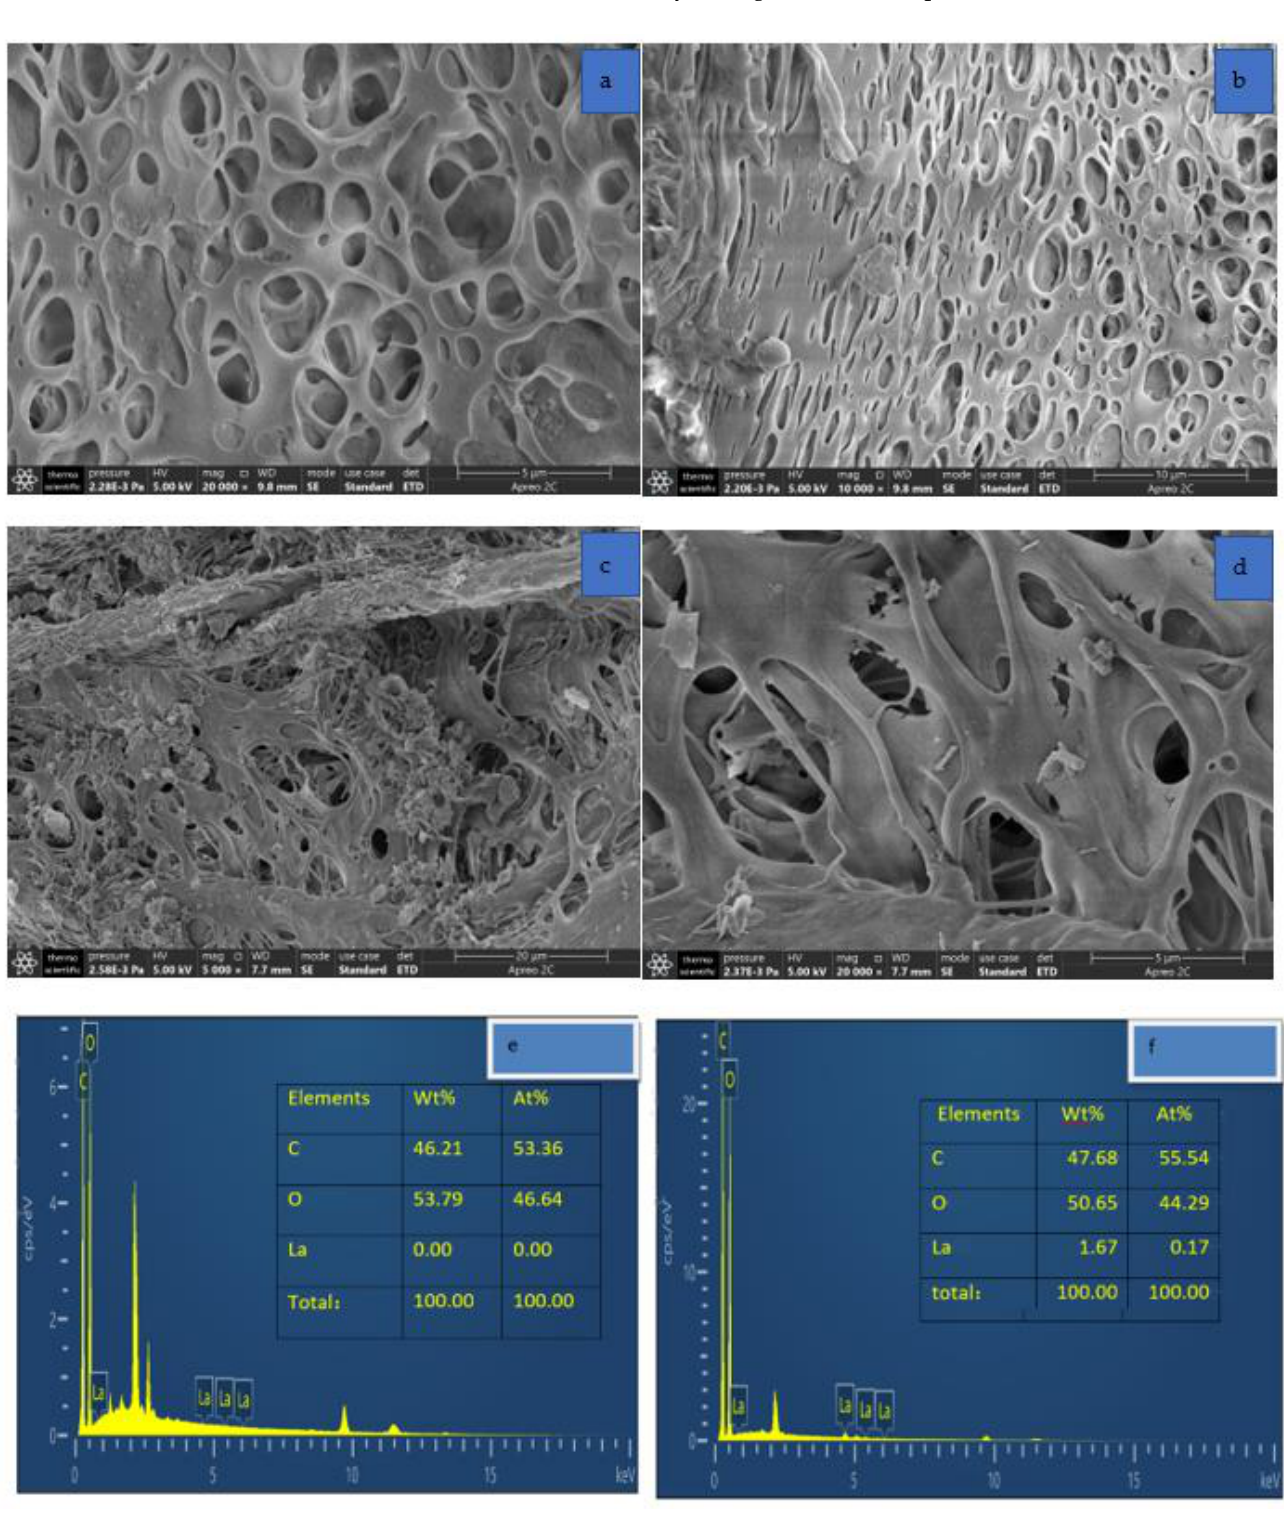
Figure 2. SEM images of sponge ( a , b ) and sponge–La ( c , d ), and EDS analysis of sponge ( e ) and sponge–La ( f ).